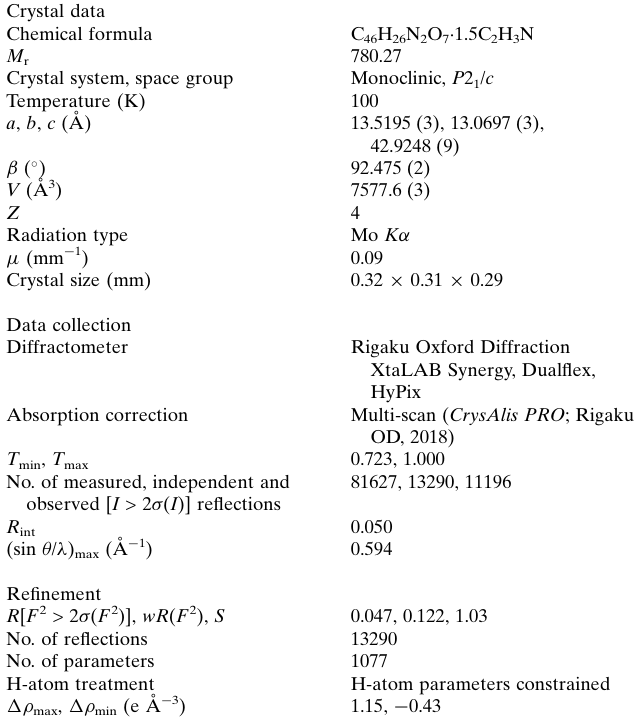
Crystal data Chemical